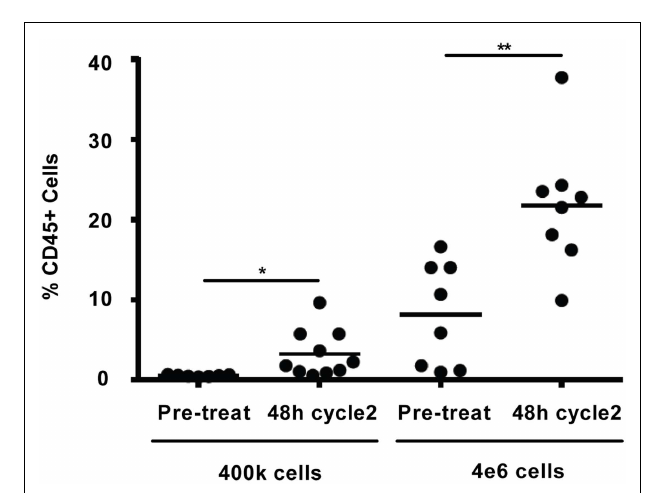
FIGURE 3 | (A) Western blot of full-length ecotropic viral integration site 1 (EVI1), a truncated form of EVI1 (EVI1 ∆ ) and PTEN expression in peripheral blood mononuclear cells at the time points indicated. No fusion of EVI1 and MDS1 was detected in these cells. GAPDH is included as a loading control. (B) Levels of PTEN mRNA measured by qPCR. Expression levels are shown as PTEN ∆∆ ct/GAPDH ∆∆ ct. Error bars indicate SEM. No statistically significant differences in mRNA